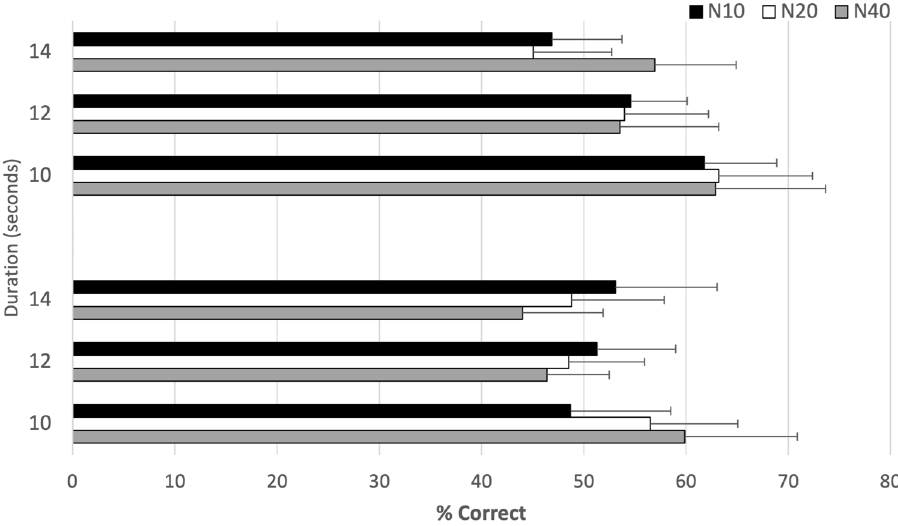
Figure 4. Percentage of correct responses as a function of steps ( N10 , N20 , N40 ) for the three duration conditions (10 s, 12 s, and 14 s) for Experiment 3 (progress bars) and Experiment 4 (throbbers). Errors bars show CI at 95%.